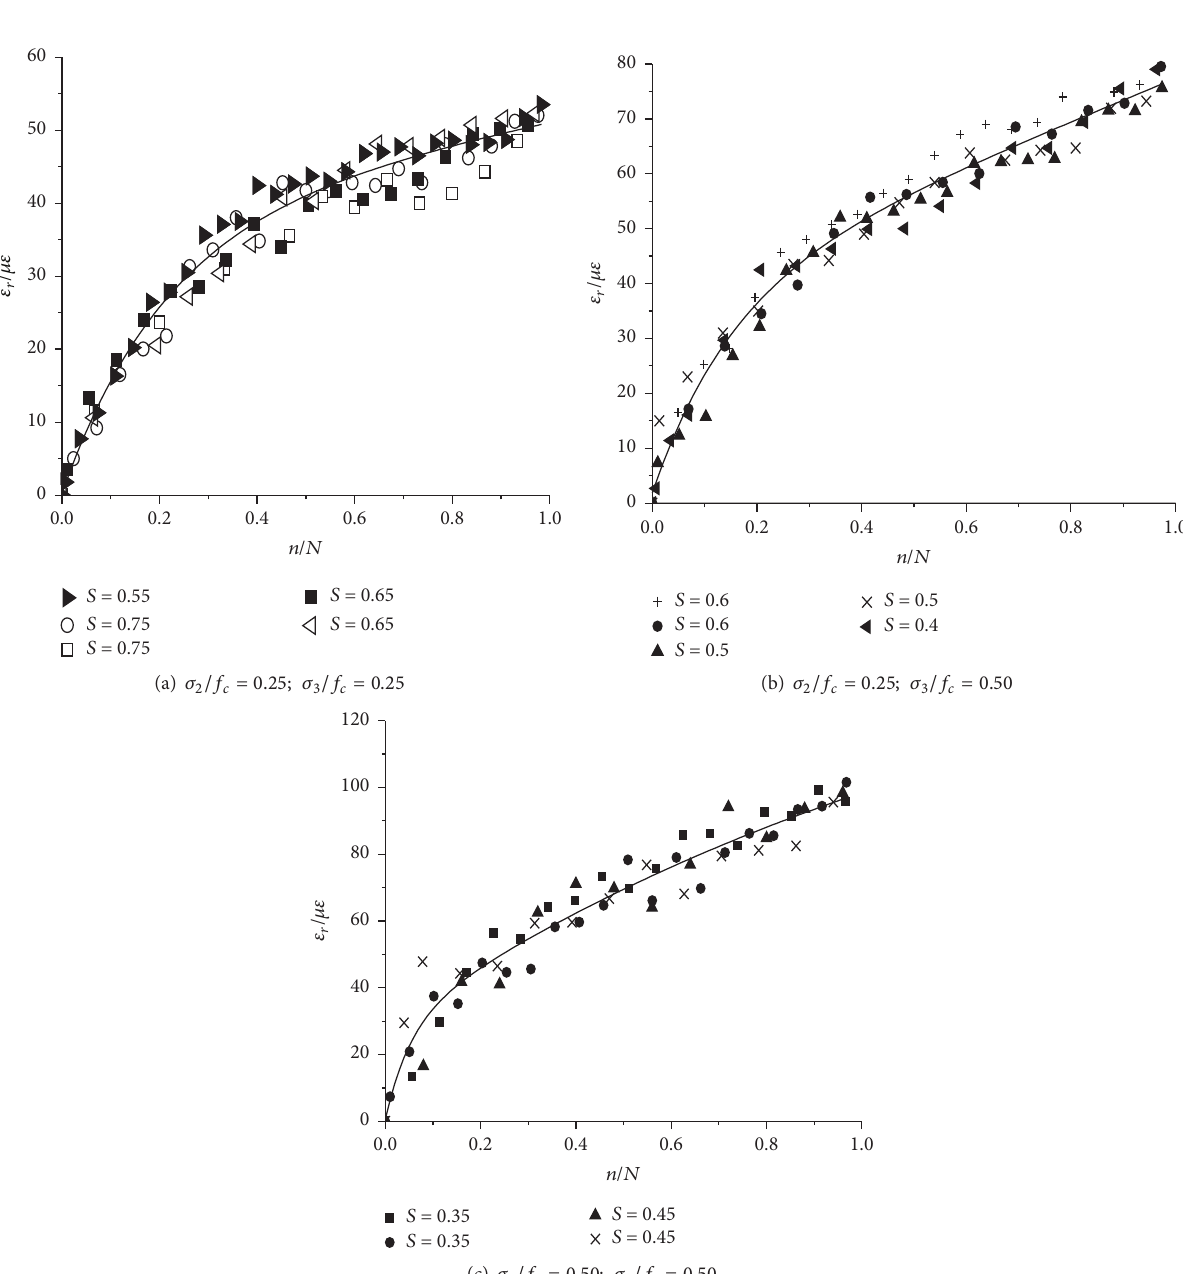
Figure 4: Relationship of residual strain and relative fatigue cycle in T-C-C constant amplitude loading.